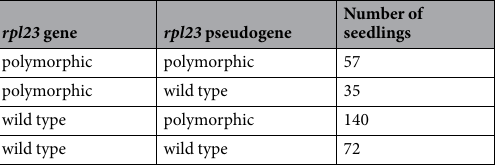
Table 3. Number of seedlings with polymorphic rpl23 gene and/or rpl23 pseudogene.